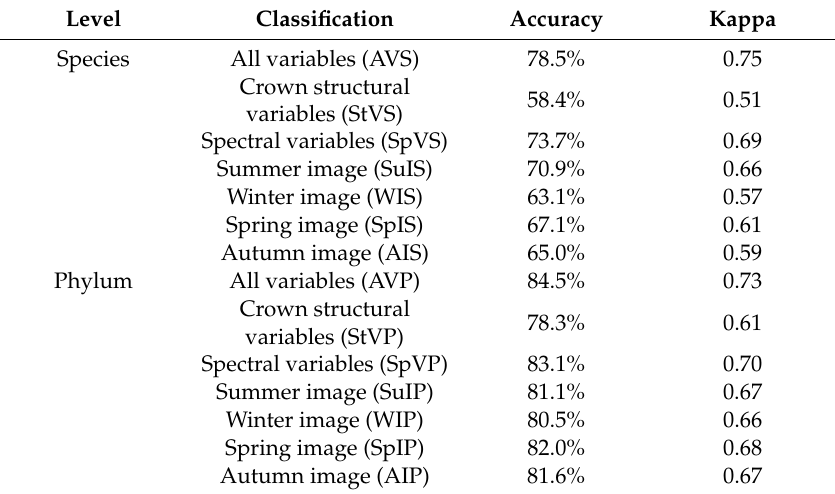
Table 4. Accuracy and Kappa values of classifications based on di ff erent combinations of variables, for both tree species and tree phylum